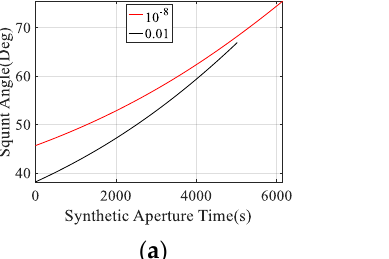
( b ) Figure 3. Squint and look-down angles along the orbit. ( a ) The eccentricity is 10 − 8 ; ( b ) The eccen- tricity is 0.01. As shown in Figure 3, the squint angle varies in a larger scope compared with the look-down angle. Furthermore, with the increase of the eccentricity, the look-down angle also varies widely. 3. Accurate Doppler Model In this section, a more accurate calculation method of Doppler parameters will be emphasized by considering the variation of the RLS within the synthetic aperture time compared with the formulas for calculating these parameters given in the previous related